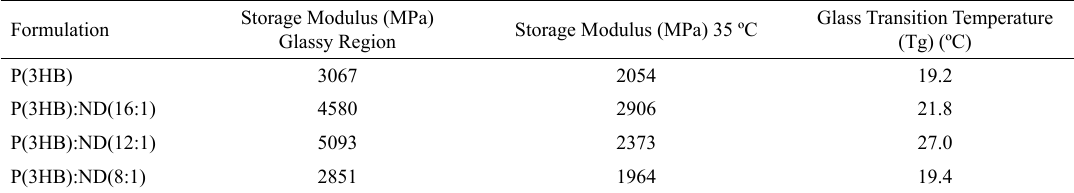
Table 3: Properties obtained by DMA for different formulations.